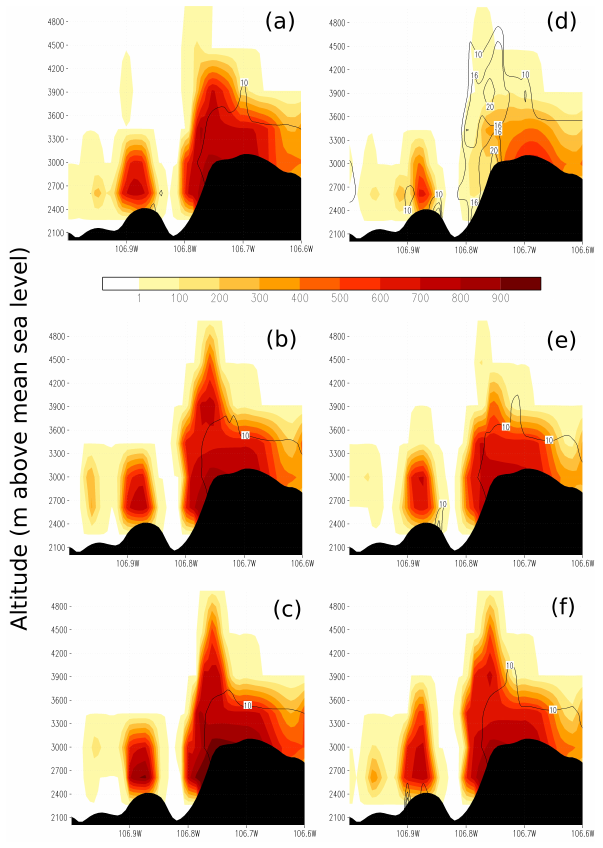
Fig. 6. Vertical cross-sections of N d (shaded;cm − 3 ) and mean droplet diameter (contoured;µm) for RAMS simulations (a) B1, (b) B7, (c) B10, (d) A1, (e) A7, (f) A10. Only mean droplet diam- eters above 10µm are contoured. The cross-section was taken at 40.455 ◦ N and terrain is blacked out.